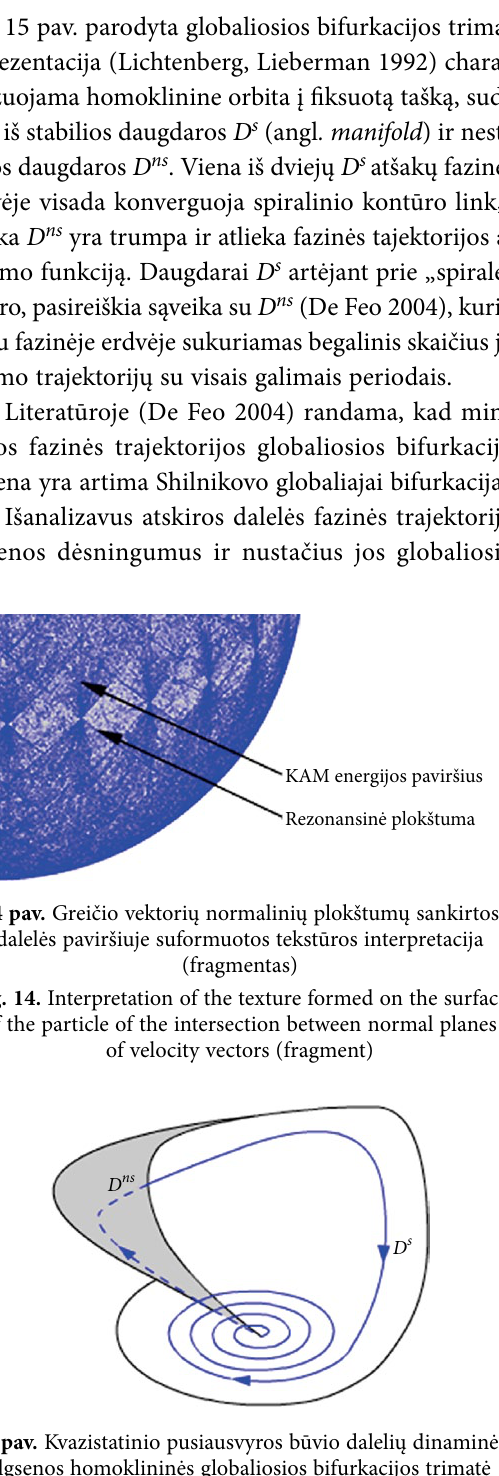
Fig. 15. Three-dimensional interpretation of homoclinic global bifurcation of dynamical behavior pertaining to particles in a quasistatic equilibrium state: here D s shows a stable phase space manifold and D ns shows unstable manifold (blue line shows the typical character of the phase trajectory)